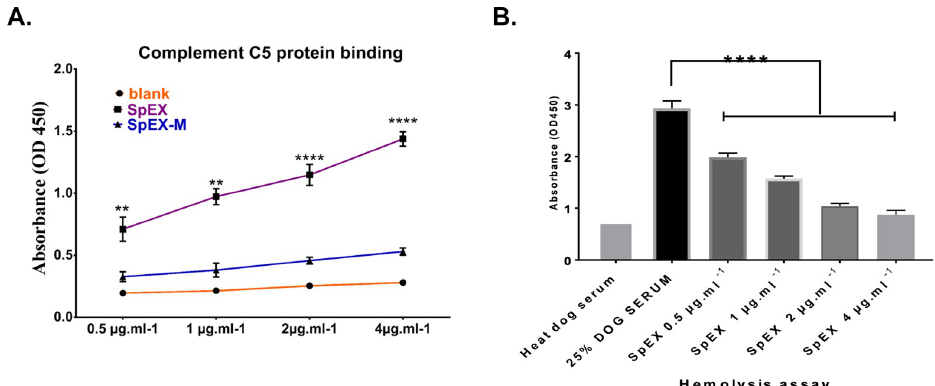
Fig 5. SpEX interferes with complement function. a. HRP-conjugated anti-6xhis tag monoclonal antibody was used at a dilution of 1/1000 to detect recombinant SpEX bound to human C5. Recombinant SpEX bound significantly higher to human C5 than recombinant SpEX-M protein (0.5 with P = 0.0171 �� , 1 μ g /ml with P = 0.0027 �� , 2 and 4 μ g /ml with P < 0.0001 ���� ). These values represent averages from three independent experiments. ( � P < 0.05 was considered significant). b. Starting at a concentration of 0.5 μ g/ml, SpEX significantly reduced the hemolysis of sensitized bovine erythrocytes compared to the positive control with P < 0.0001 ���� . SpEX at a concentration of 4 μ g/ ml showed no significant difference in hemolysis compared with the negative control. The values represent averages from three independent experiments. ( � P < 0.05 was considered significant).